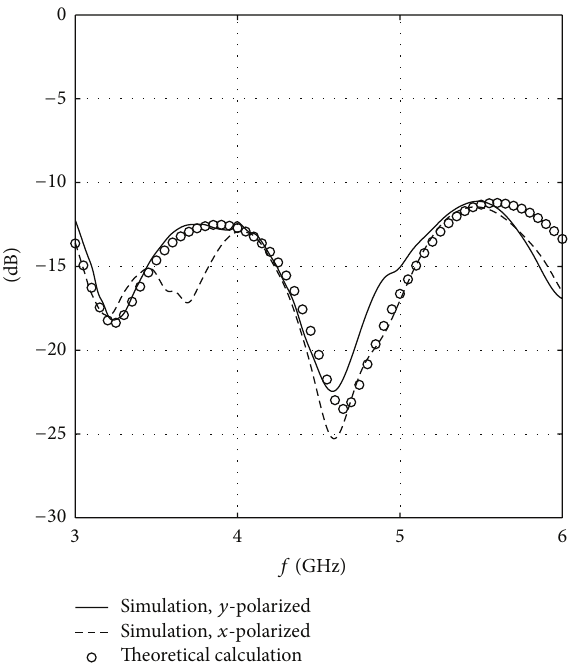
Figure 6: Theoretical and simulated results of the normalized specular far-field reflectance of the nonuniform surface as instance under normal incidence.